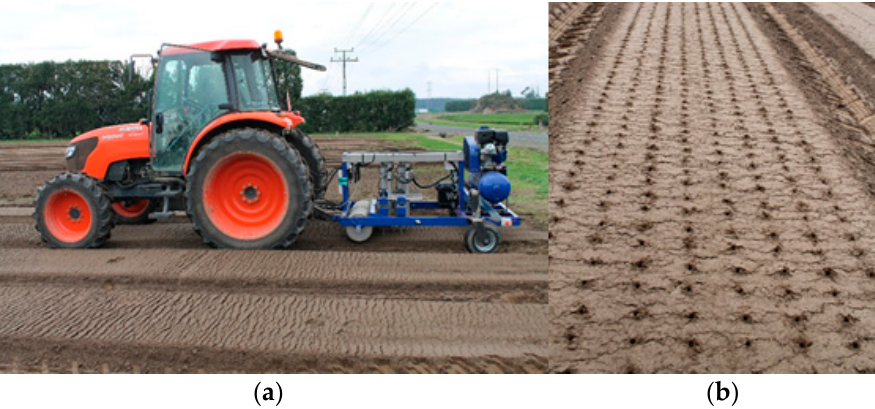
Figure 13. Dibbler field tests. ( a ) The dibbler and the tractor. ( b ) Planting bed with holes dibbled.